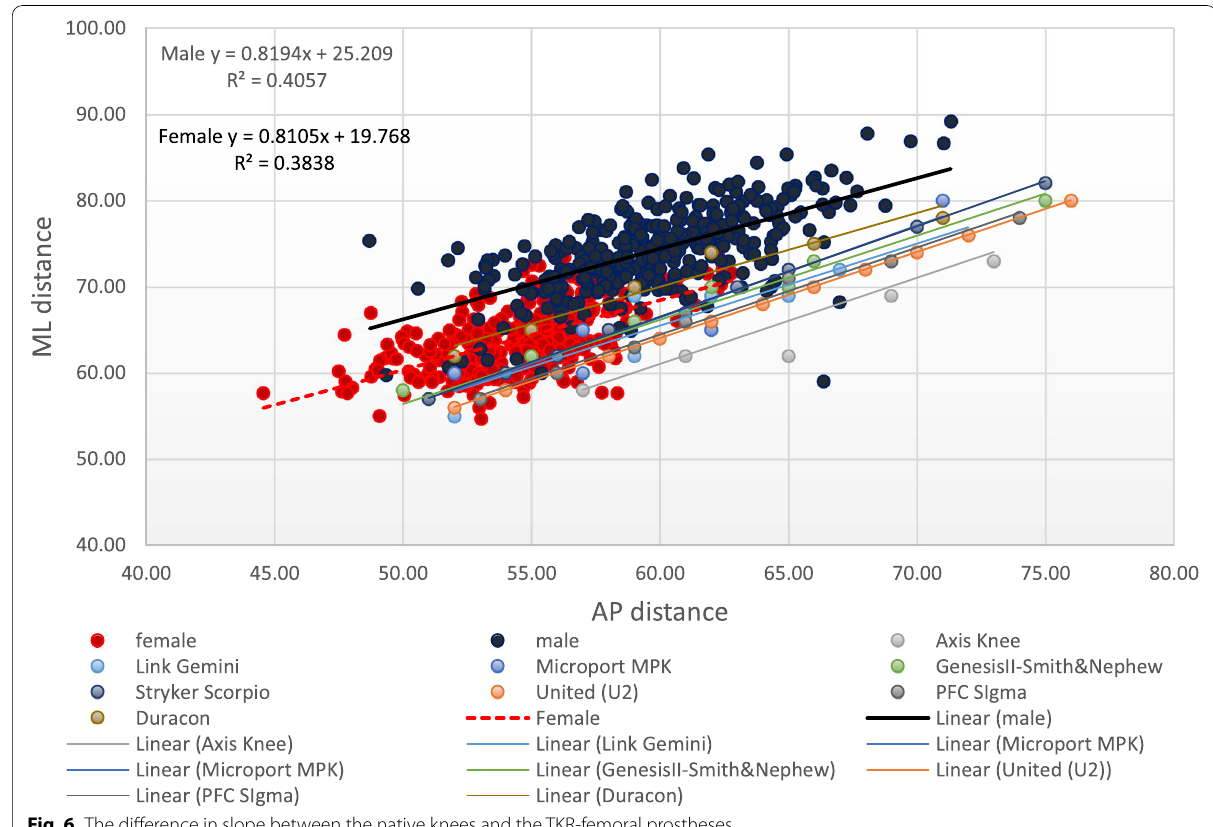
Fig. 6 The difference in slope between the native knees and the TKR-femoral